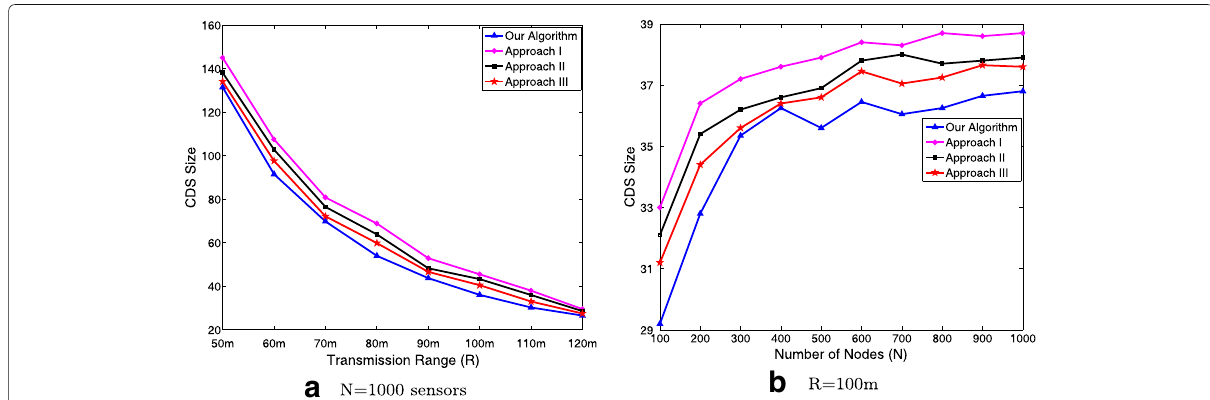
Fig. 6 Comparing results in the 600 × 600m 2 detection area. a The average performance of four algorithms, when N = 1000 sensors and R changes from 50 to 120 m. b The average performance of four algorithms when R = 100m and N changes from 100 to 1000 sensors